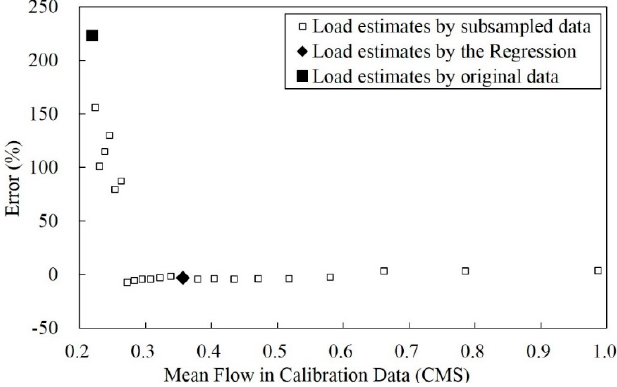
Figure 6. Annual sediment load estimate improvement when excluding water quality samples (USGS station number 02119400, monthly fixed sampling strategy on 19th of every month). Table 5. Improvement of the poorest annual sediment load estimates by MFC fitting.